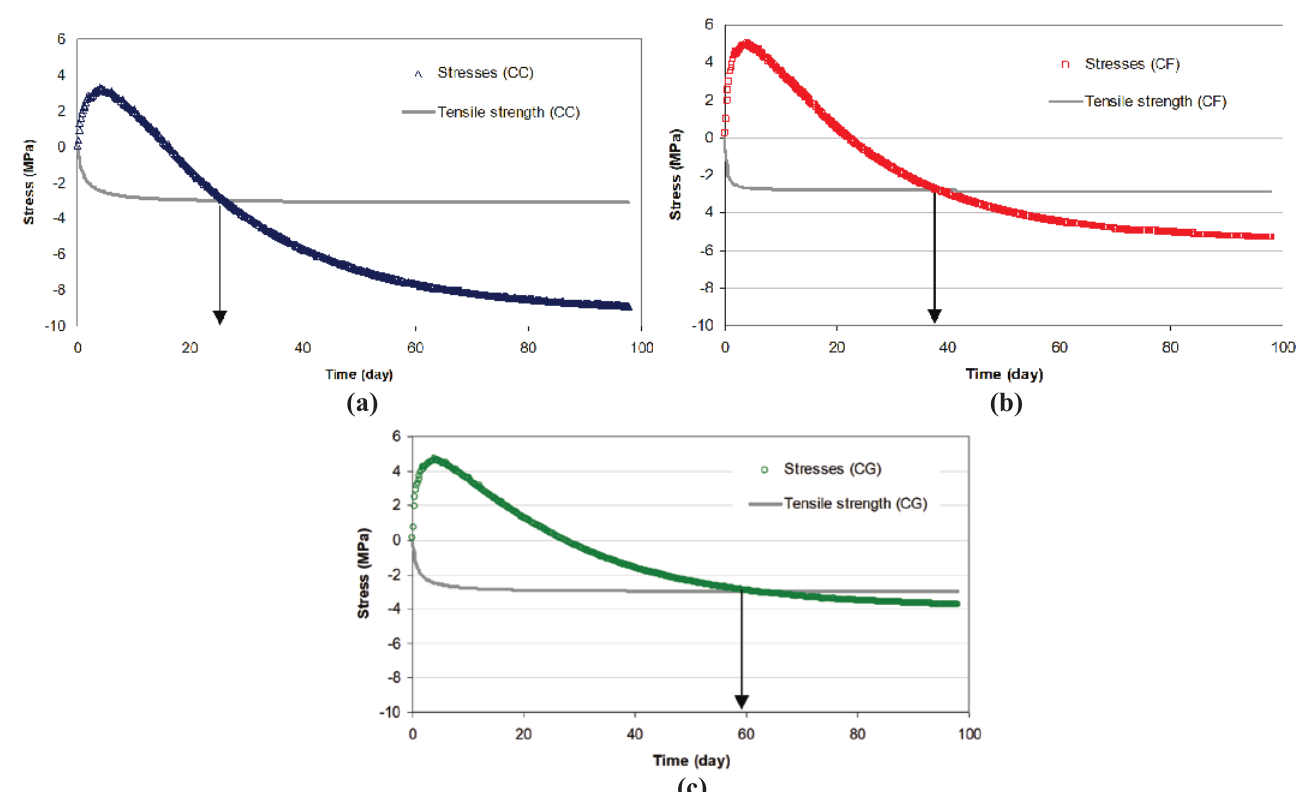
Evolution of thermal stresses versus tensile strength (element 427): (a) of concrete (CC); (b) of concrete (CF) and (c) of concrete